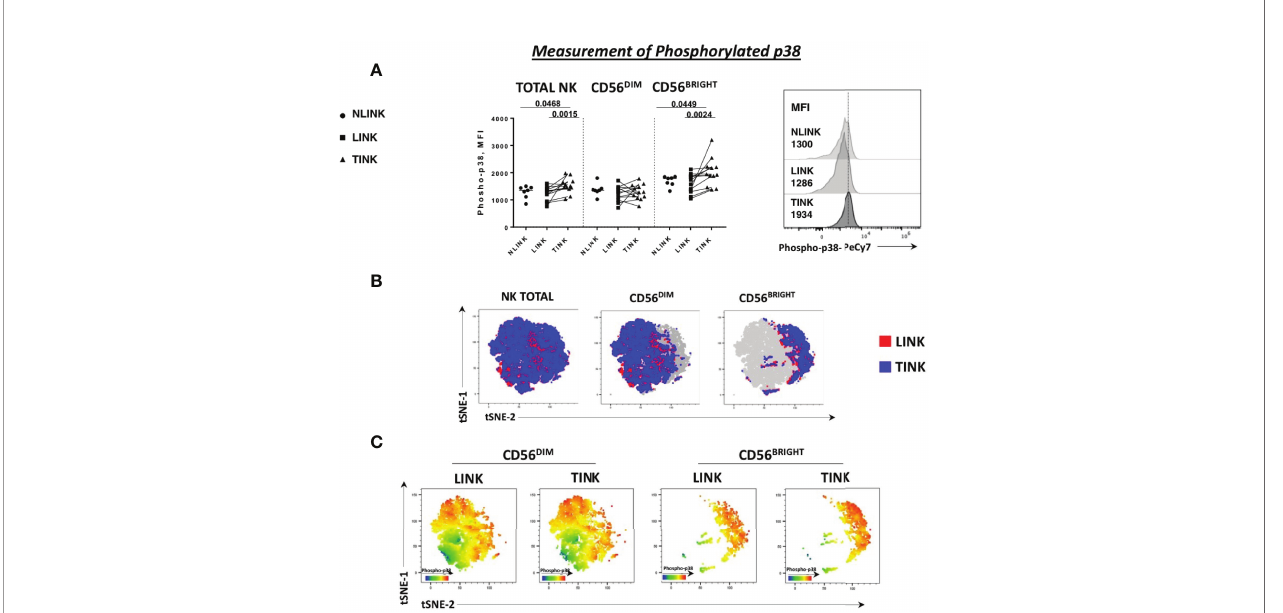
FIGURE 3 | Phosphorylation status of p38 protein in NK cells in fi ltrating hepatocellular carcinoma (TINK), HCC-surrounding liver (LINK), and normal liver tissue (NLINK). (A) On the left, median fl uorescence intensity (MFI) of phospho-p38 protein in total, CD56 DIM , and CD56 BRIGHT NK-cell subpopulations from TINK ( n = 12), LINK ( n = 12), and NLINK ( n = 7). Right panel: detail of phospho-p38 MFI values of total NK cells from different study groups. Statistical analysis was performed by Wilcoxon matched pairs test (LINK vs . TINK) and Mann-Whitney test (NLINK vs . TINK and NLINK vs . LINK). (B) To show the segregation of NK subsets, we generated a two-dimensional map of NK cells from paired TINK and LINK from all the experimental samples. tSNE was applied to fl ow cytometry data (single-cell expression values). (C) tSNE colored by the expression intensity of phospho-p38 protein in TINK and LINK samples. Red indicates upregulation, while blue indicates downregulation. Different color shades represent intermediate levels.